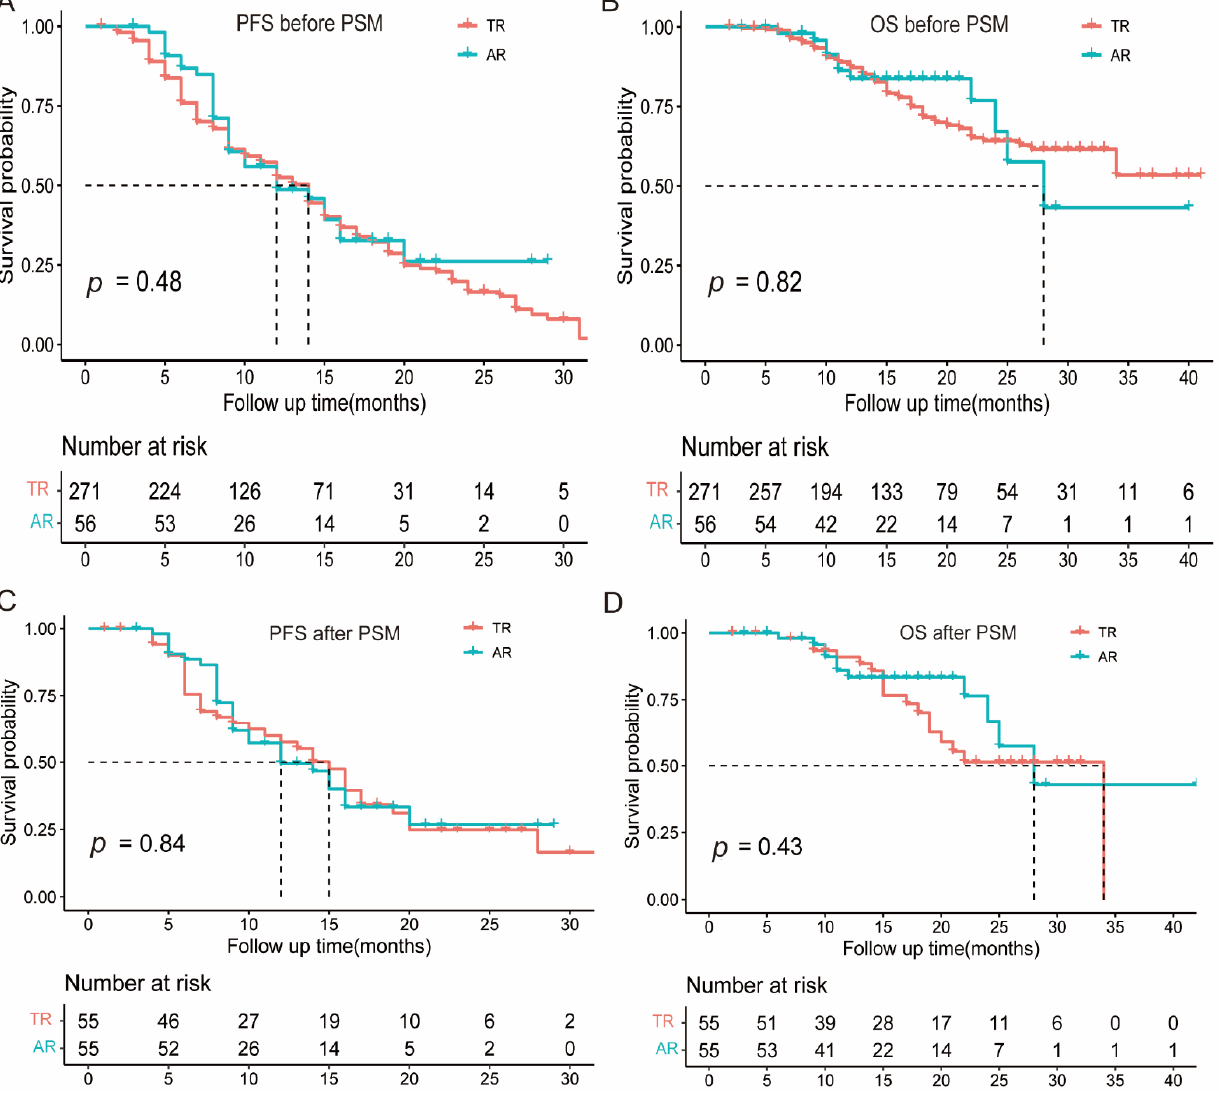
Figure 3. Kaplan–Meier analysis of PFS and OS. Kaplan–Meier plots of PFS ( A ), and OS ( B ) in patients with AR and TR before PSM. Kaplan–Meier plots of PFS ( C ), and OS ( D ) in patients with AR and TR after PSM. AR, atypical response; TR, typical response.